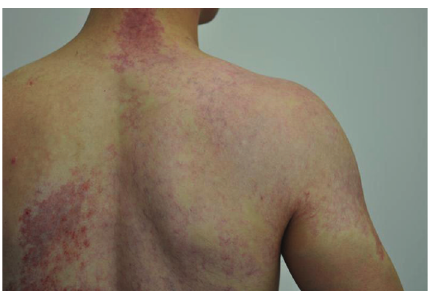
Figure 4: Capillary malformation, back.